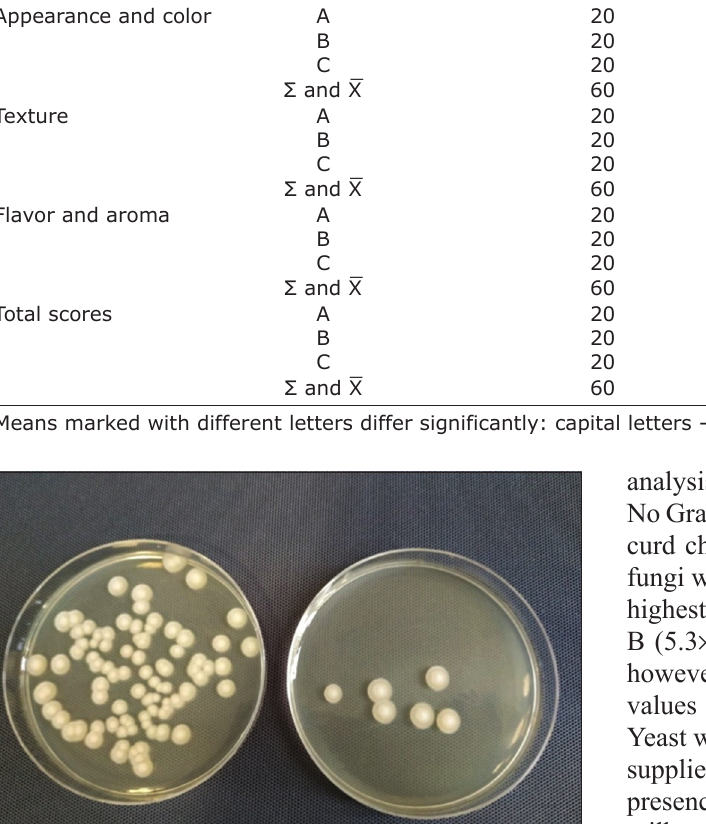
Figure-2: Colonies of microorganisms present in curd cheese samples cultured on Sabouraud medium ( own resources ).